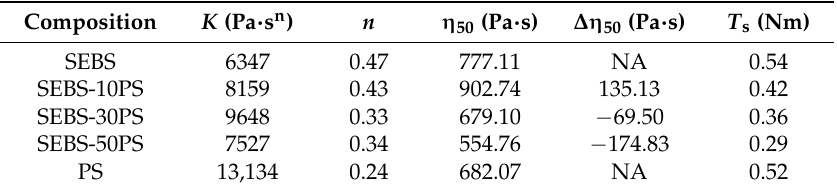
Table 4. Rheological parameters, shear viscosity and torque